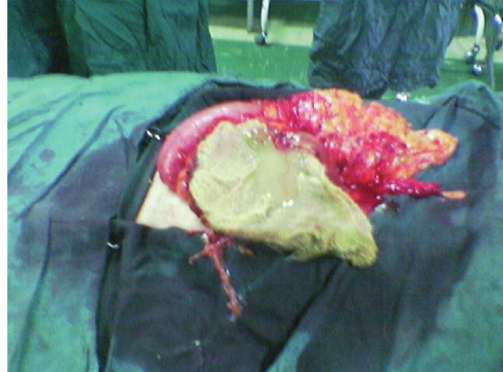
Figure 2: The gauze removed completely from inside of the cyst.